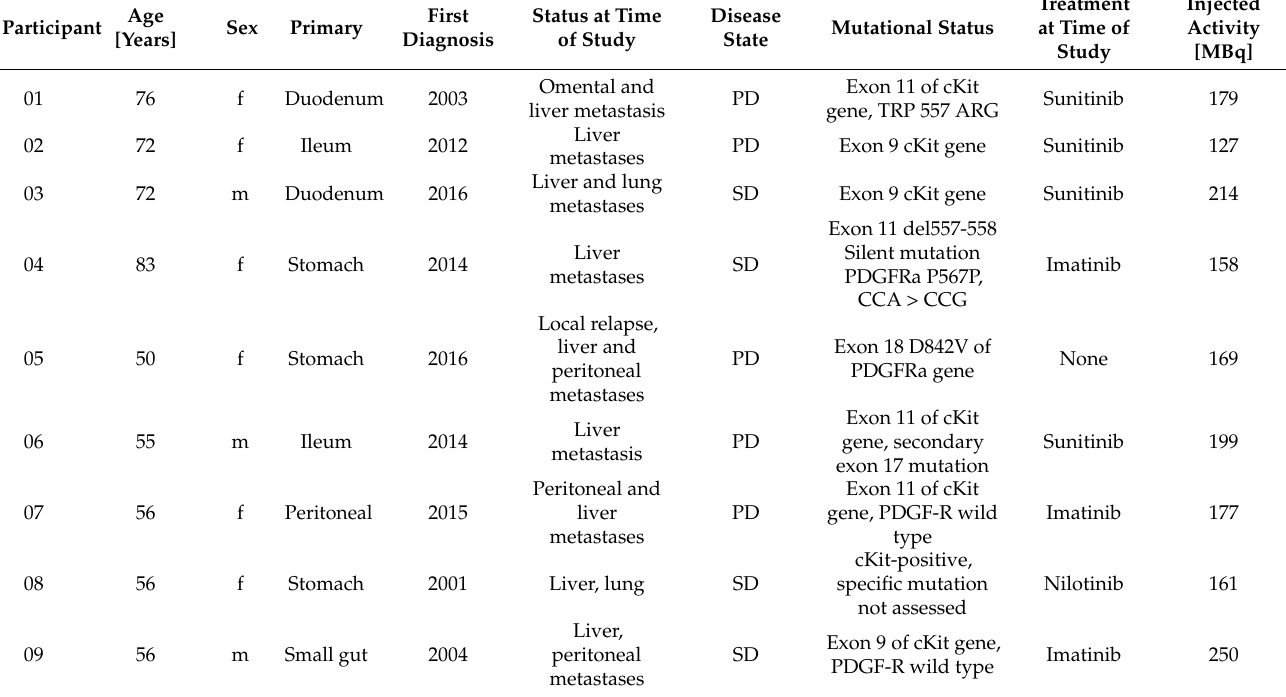
Table 1. Patient characteristics and injected